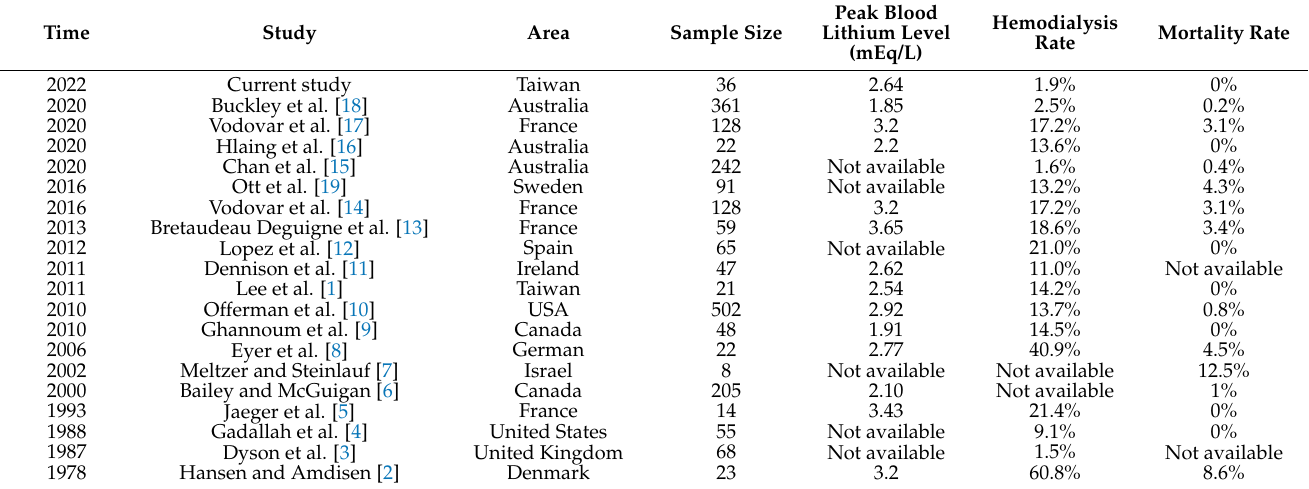
Table 1. Literature study on the outcomes of hemodialysis treatment for patients with lithium